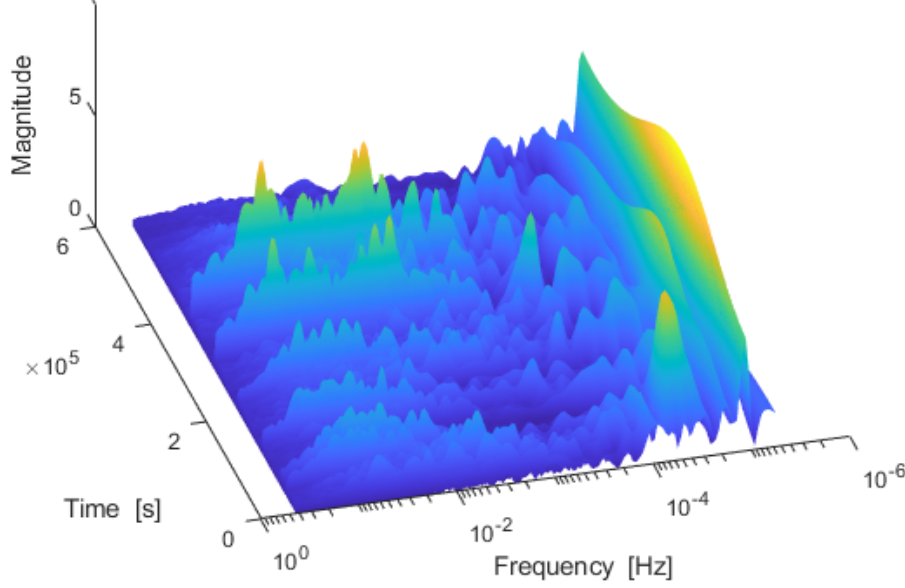
Figure 4. Three-dimensional scalogram showing heat flux features.